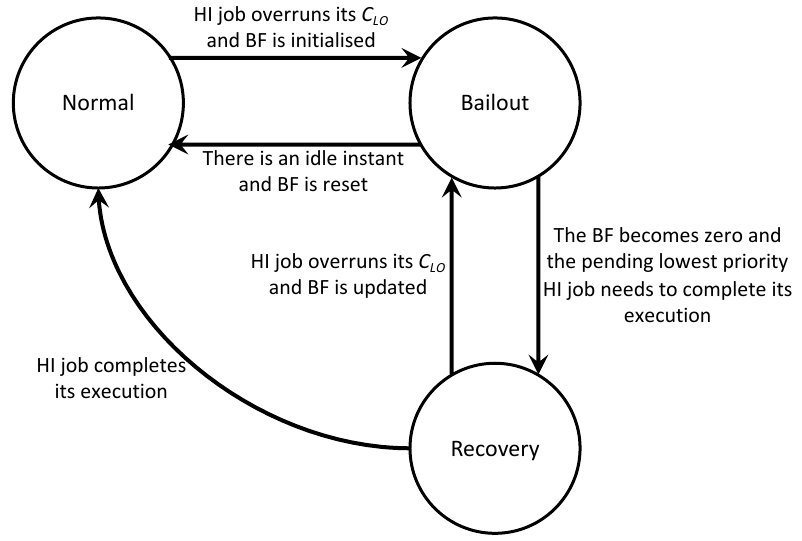
Figure 2. Execution mode changes in